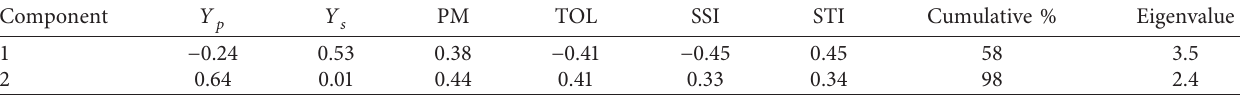
Table 5: Eigenvalue and vectors of principal component analysis for potential yield (YP), stress yield (YS), and stress tolerance indices. Component